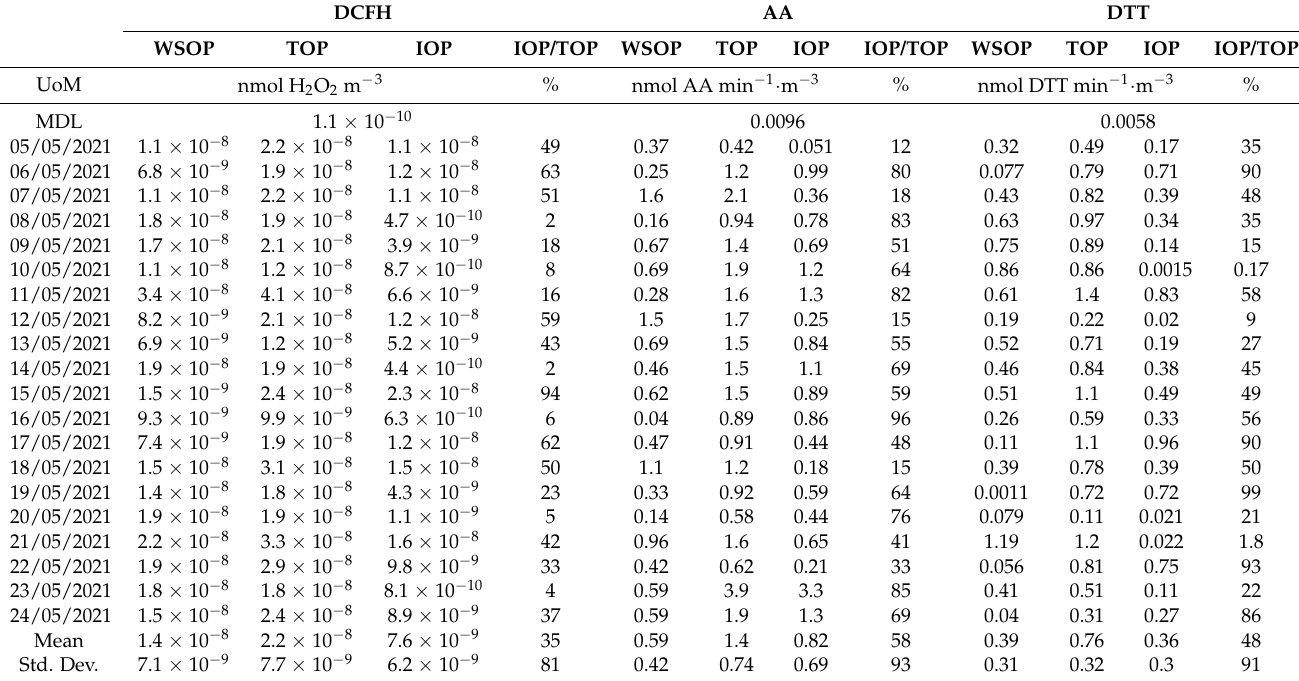
Table 2. WSOP, TOP, and IOP values for the OP DCFH , OP AA , and OP DTT assays applied to the 20 PM 10 samples collected at